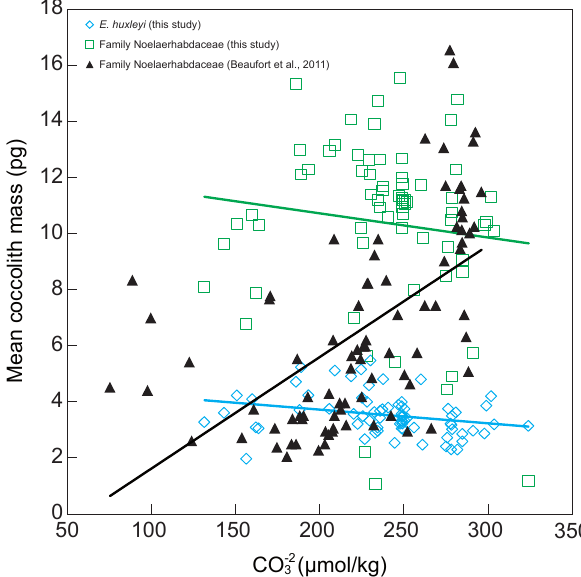
Fig. 4. Comparison between the averaged mass of E. huxleyi (this study, open blue diamonds), the averaged mass of the coccoliths belonging to the family Noëlaerhabdaceae in the surface sediment (including E. huxleyi , this study, green open squares), the averaged mass of the coccoliths belonging to the family Noëlaerhabdaceae in the plankton (including E. huxleyi , Beaufort et al., 2011, black triangles) and the carbonate ion concentration ([CO 2 − green and black lines show the linear regression for the three data